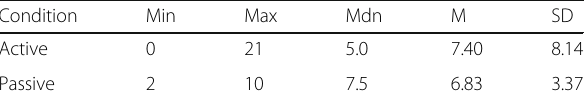
Table 2 The number of speed warnings by the condition Condition